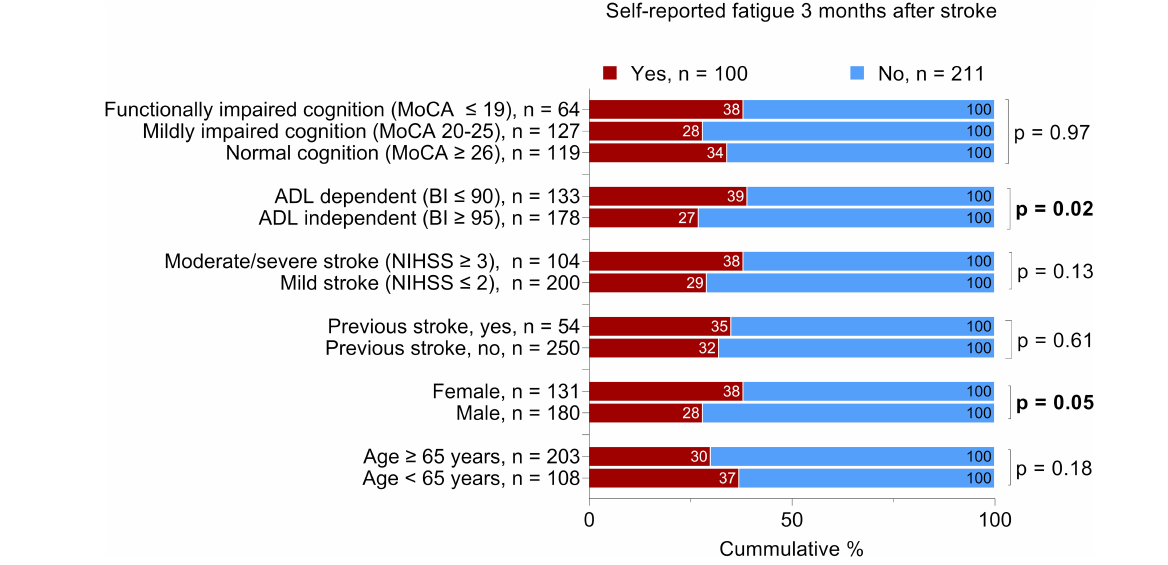
Frontiers in Human Neuroscience |